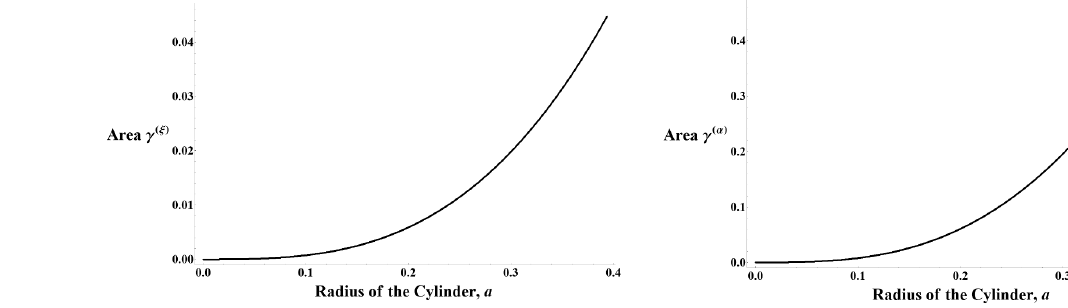
Figure 1 . γ ( ξ ) ( a ) = 0 . 73228506 a 3 + . . . , from a = 7 . 87386 × 10 − 5 to a = 0 . 393693 , 5000 data points.